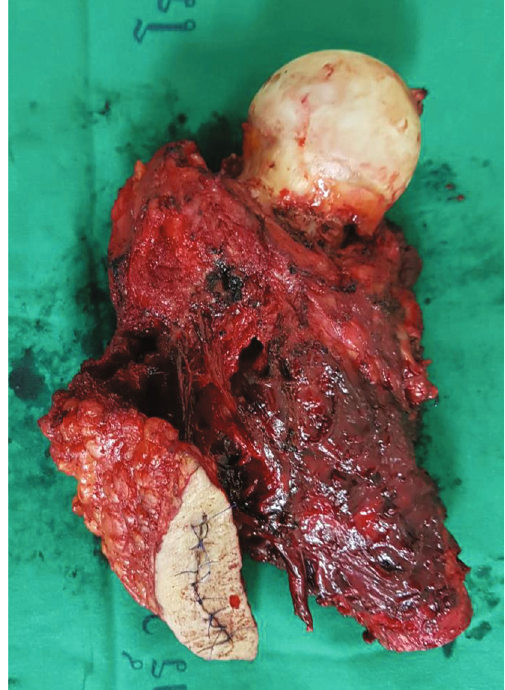
Figure 4: Specimen of proximal femur includes biopsy tract after en bloc